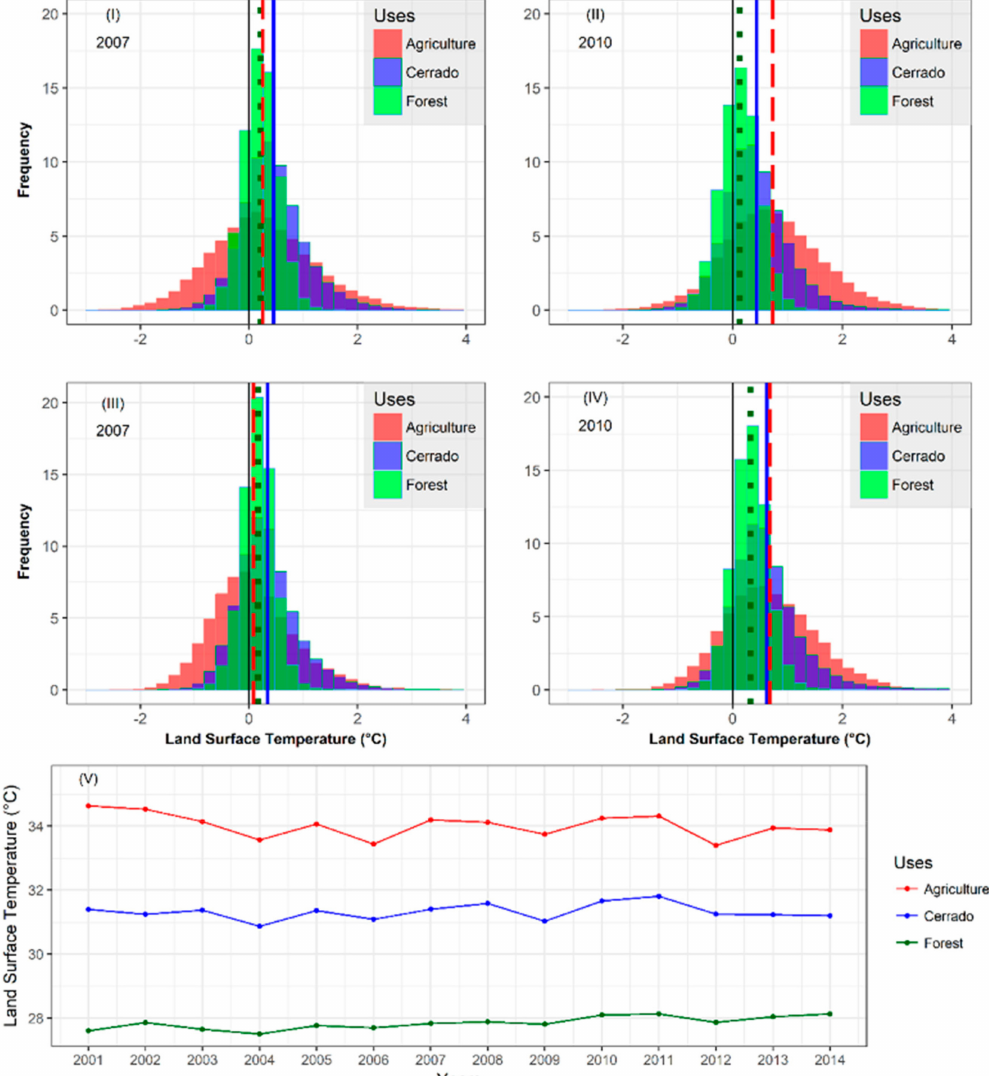
Figure A1. Histograms of the variation in surface temperature for the principal land covers in the Brazilian state of Mato Grosso during the drought events of 2007 and 2010. The dotted lines (green = forest; blue = savanna; red = cropland) represent the means recorded in each type of land cover. In graphs ( I , II ), ∆ e is the di ff erence between the mean for the year of extreme drought ( Ae ) and the biannual mean ( b ). In graphs ( III , IV ), ∆ e is the di ff erence between the mean for the year of extreme drought ( Ae ) and the historical mean ( b ). Graph ( V ) shows the variation in surface temperature between 2001 and